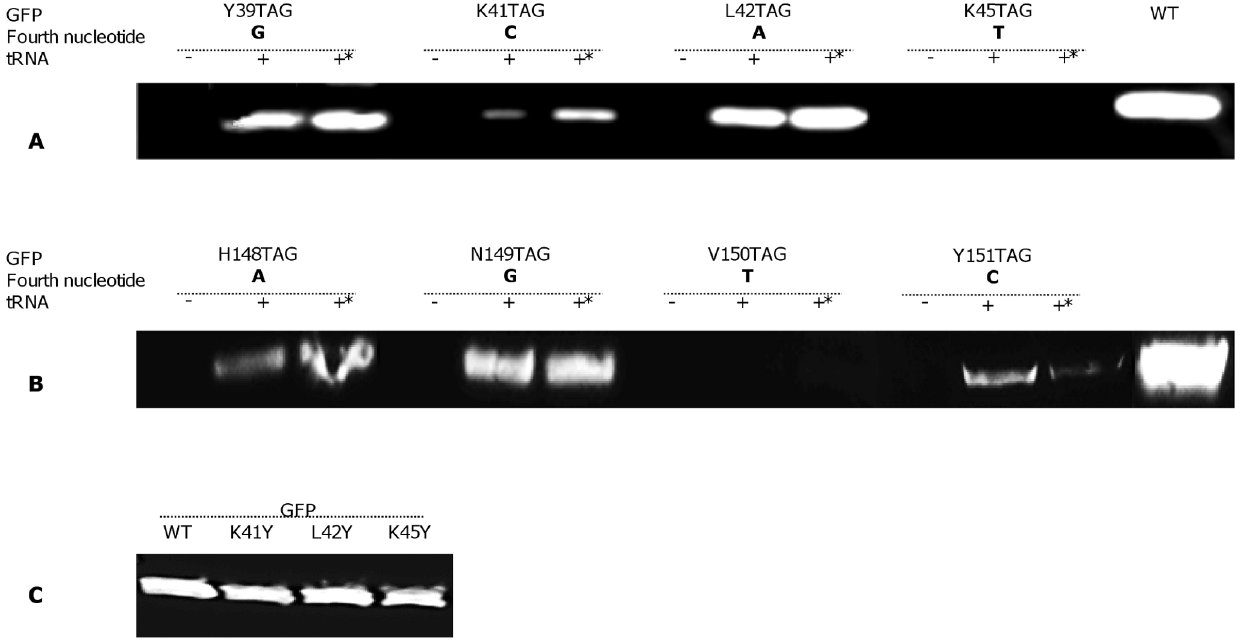
Figure 3. Cell-free expression of WT GFP and tyrosine-incorporating mutant GFP, as visualized by Western blot. (A and B) Co- translational incorporation of tyrosine at different positions in response to the amber stop codon was achieved by adding purified Mj TyrRS (200 m g/ mL) and two types of suppressor tRNA (480 m g/mL) to the reaction mixture (tRNA denotes synthetic Mj tRNA CUA , *– tRNA CUAOpt ). (C) Western blot visualization of the expression level of GFP WT and tyrosine-substituted proteins.